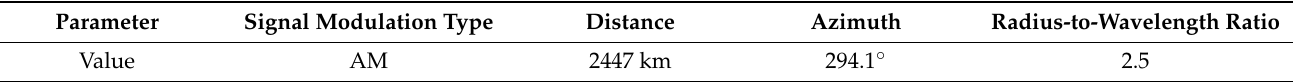
Table 2. List of experimental parameters.